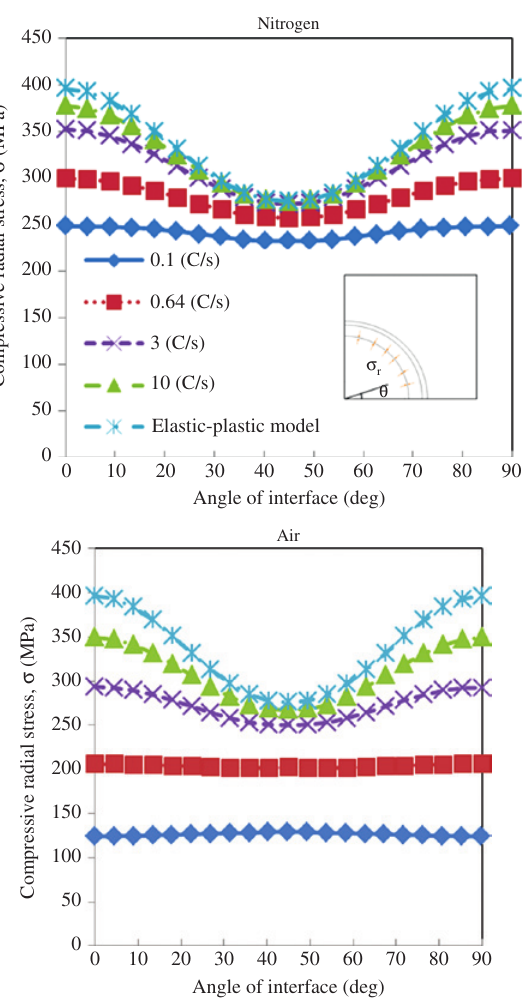
Figure 6: Distributions of the radial residual stress within the com- posite along the radial direction in air and nitrogen environments.